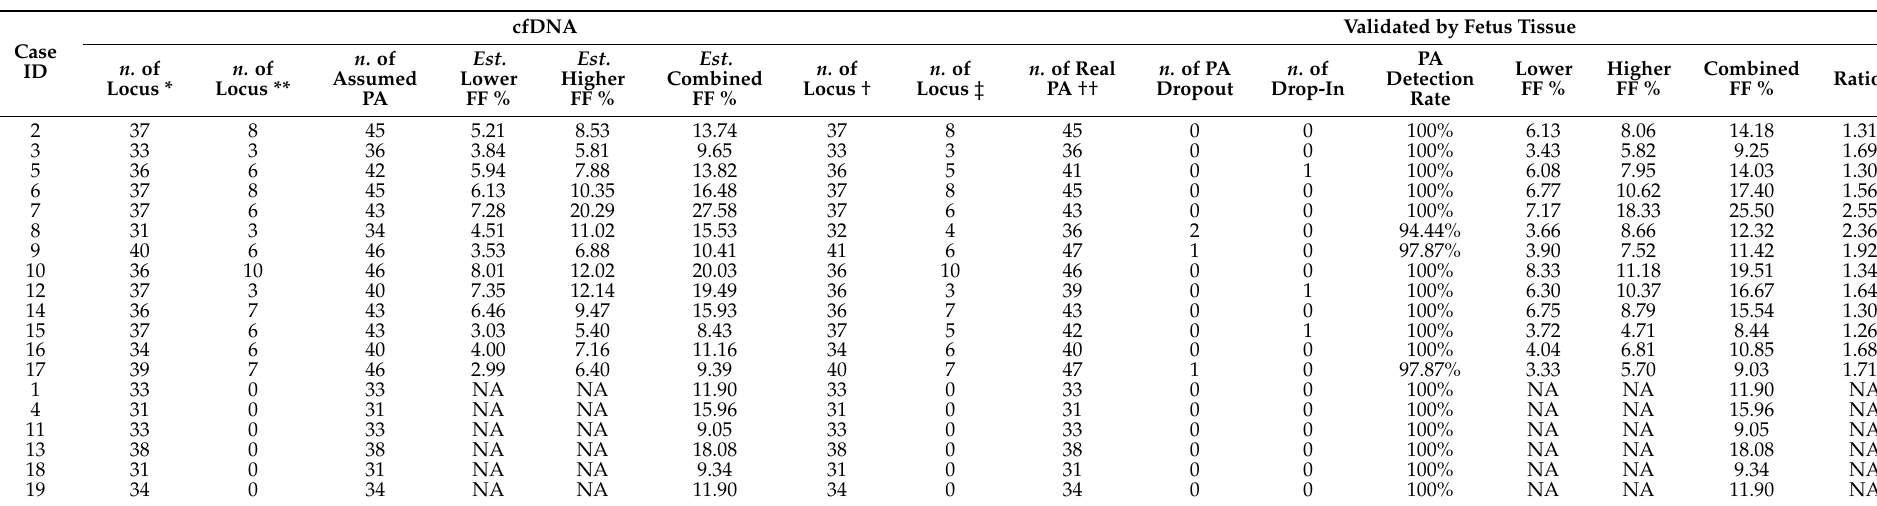
Table 1. Detailed information for the analysis of fetus-specific microhaplotype alleles (paternal alleles) in cfDNA attained from 19 twin